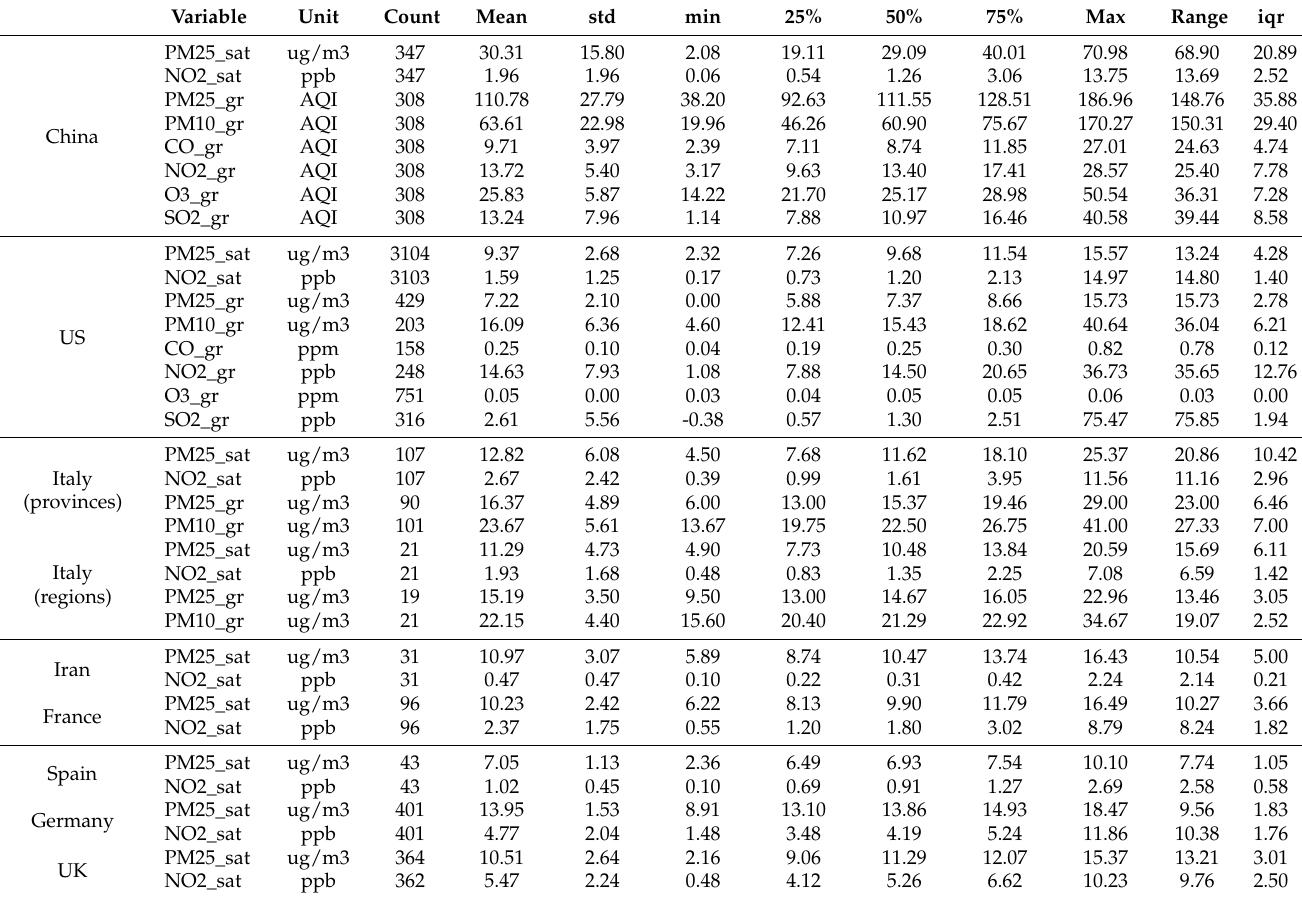
Table A1. Descriptive statistics for the air pollution variables in the eight analysed countries.